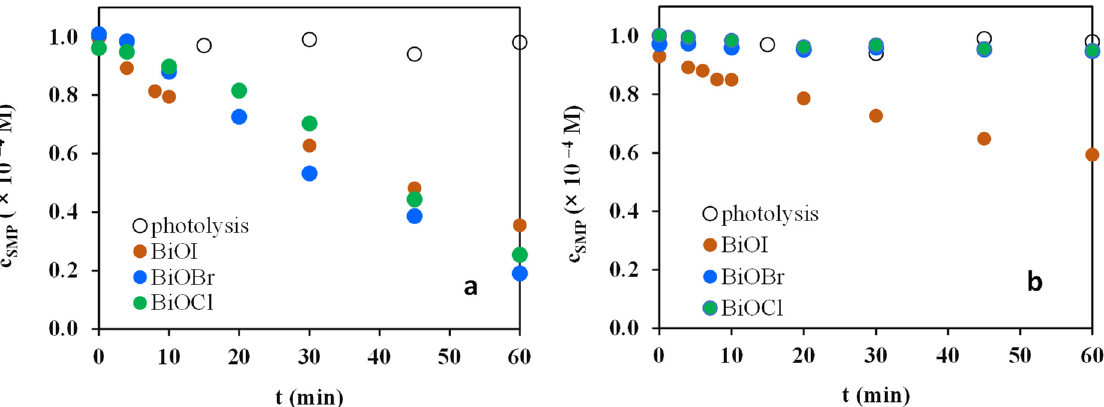
Figure 4. Transformation of SMP in aerated BiOX suspensions under UV ( a ) and Vis ( b ) irradiation. Opposite the HQ and SMP, the relative adsorbed amount of TRIM was 39% for BiOI. Lower values, 6% for BiOBr, and less than 2% for BiOCl were determined. To distinguish the amount of adsorbed and transformed TRIM; NaF solution was added to the samples for TRIM desorption before analysis [48]. Opposite to the good adsorption properties, no more than 6% of TRIM transformed in BiOX-containing suspension, even in the case of